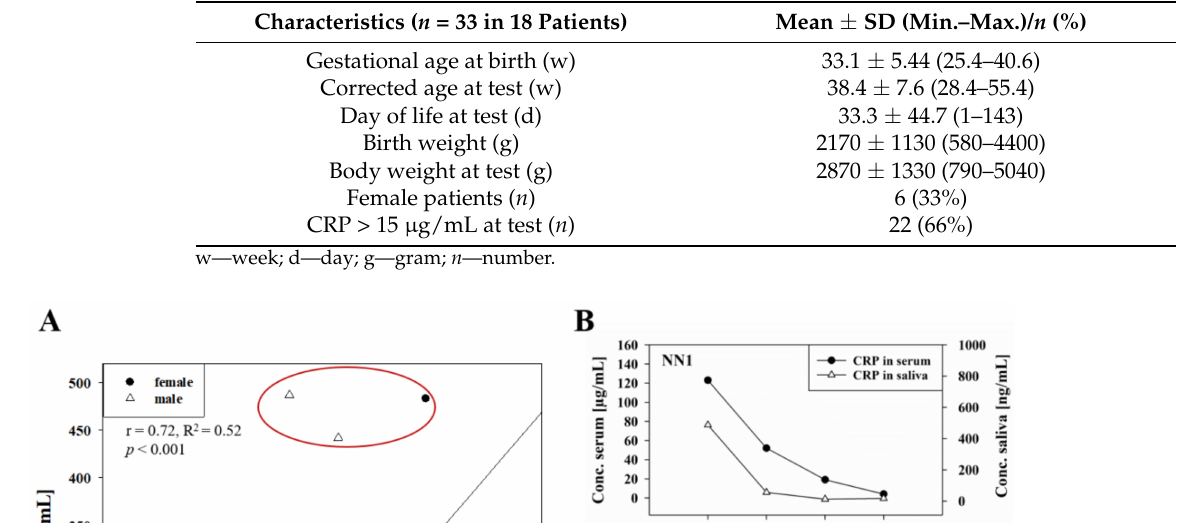
Table 2. Characteristics of neonates at test with corresponding serum C-reactive protein (CRP) concentrations shown as mean ± SD (minimum (min.)–maximum (max.)) or numbers ( n ) and percentage (%).